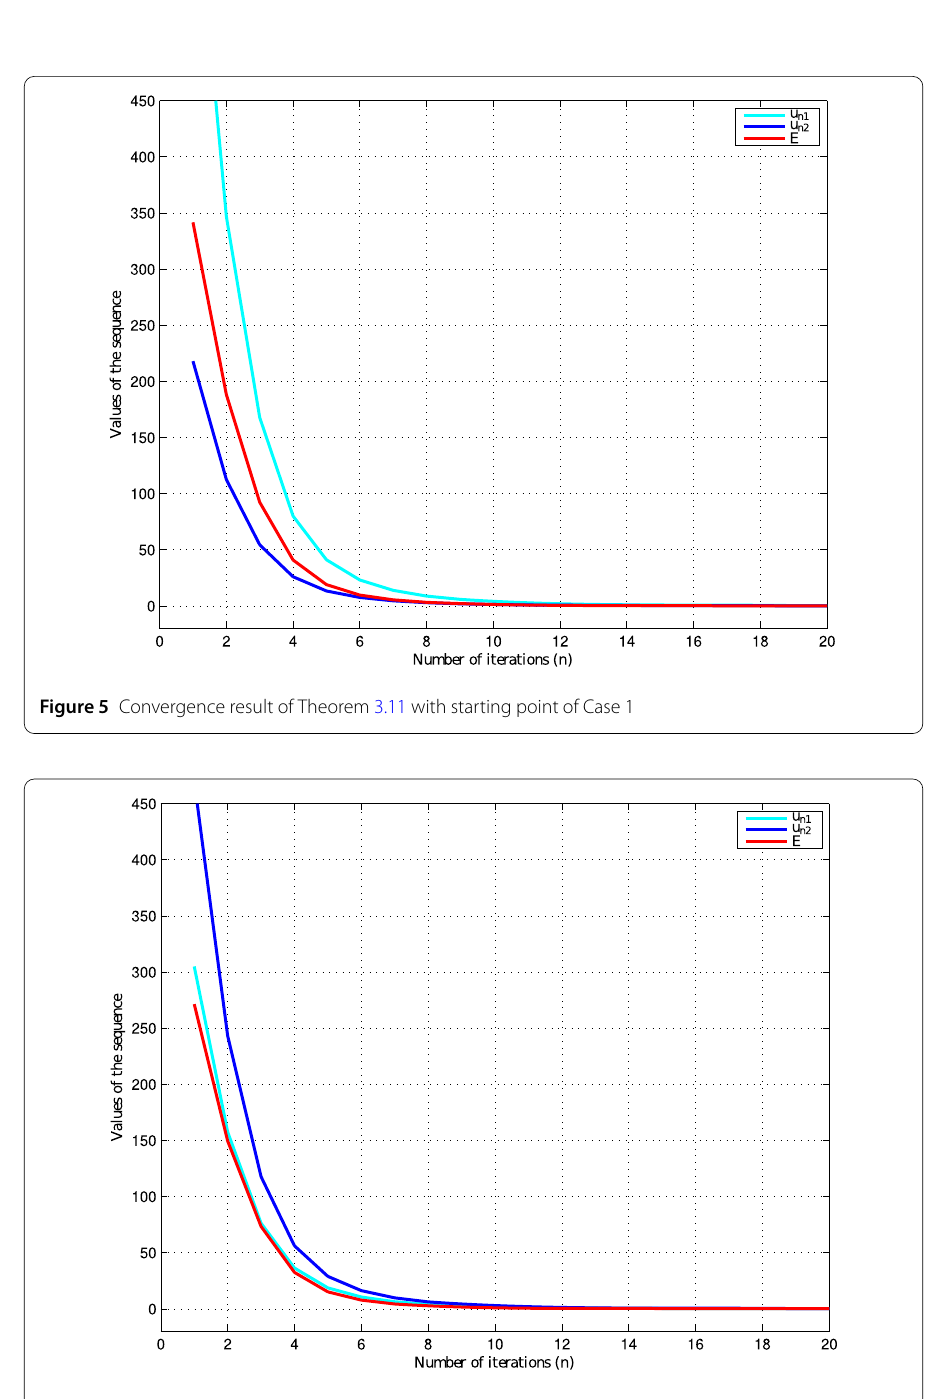
Figure 6 Convergence result of Theorem 3.11 with starting point of Case